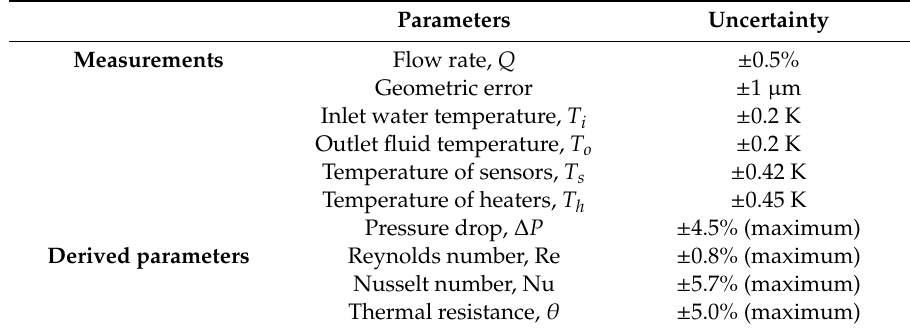
Table 1. Experimental